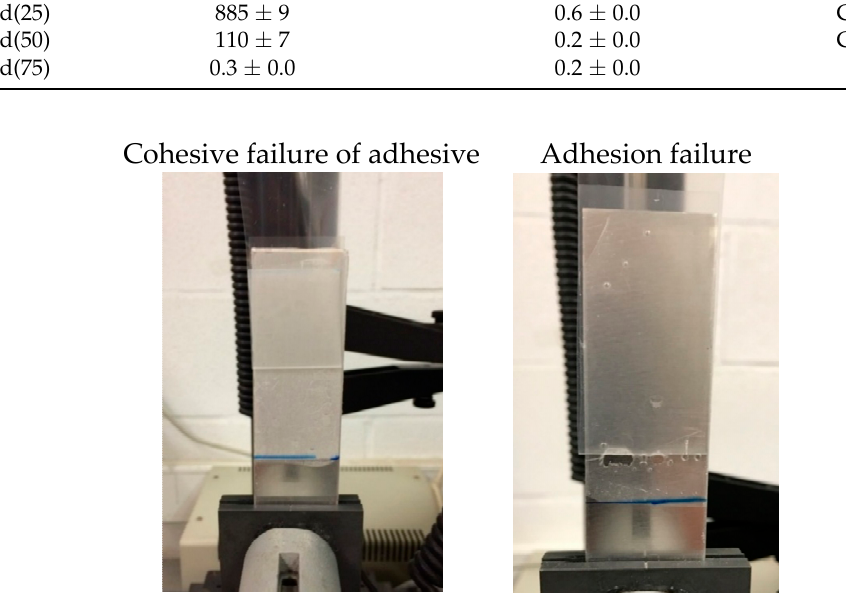
Figure 10. Loci of failure of aluminum 5754/TPU PSA joints.